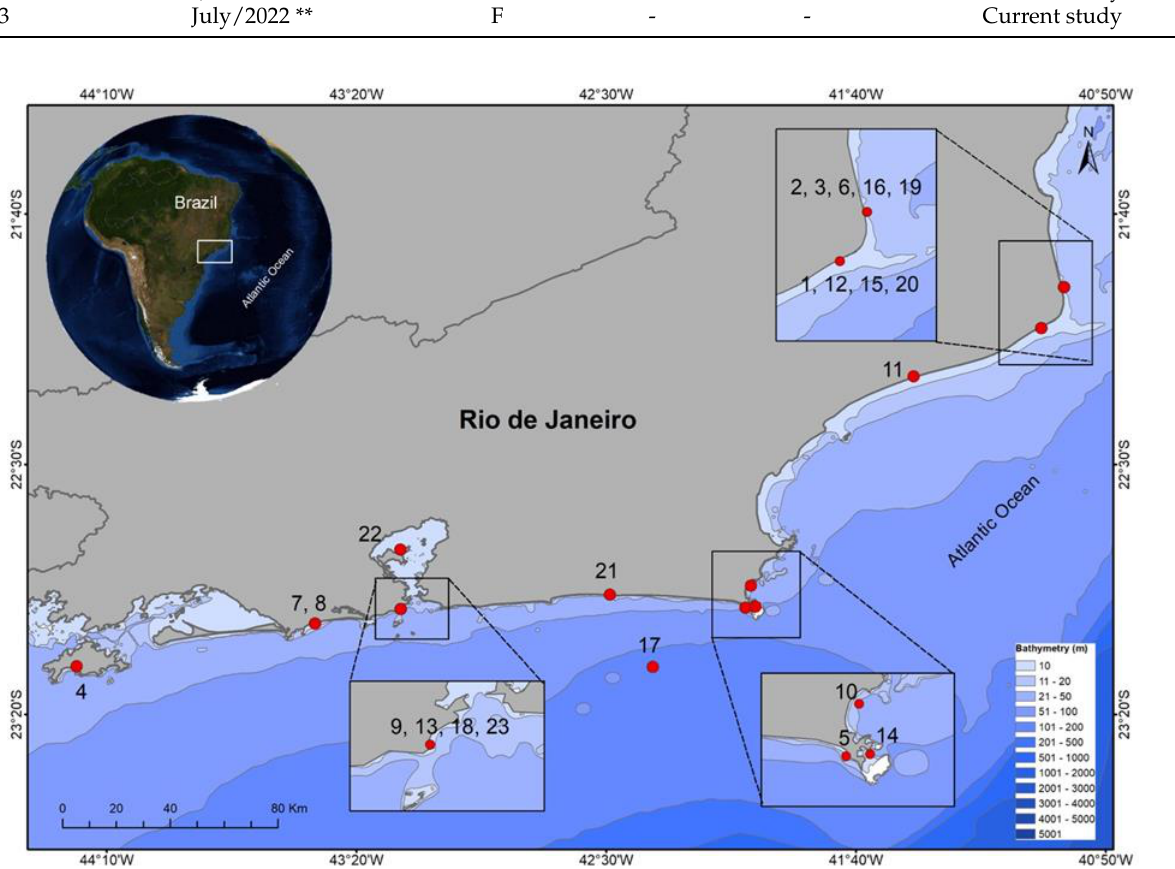
Figure 2. Map of the distribution of Galeocerdo cuvier records obtained off the coast of the state of Rio de Janeiro. Each study is identified by the code displayed in Table 1. Table 1. Morphometric Galeocerdo cuvier data for the records obtained off the coast of the state of